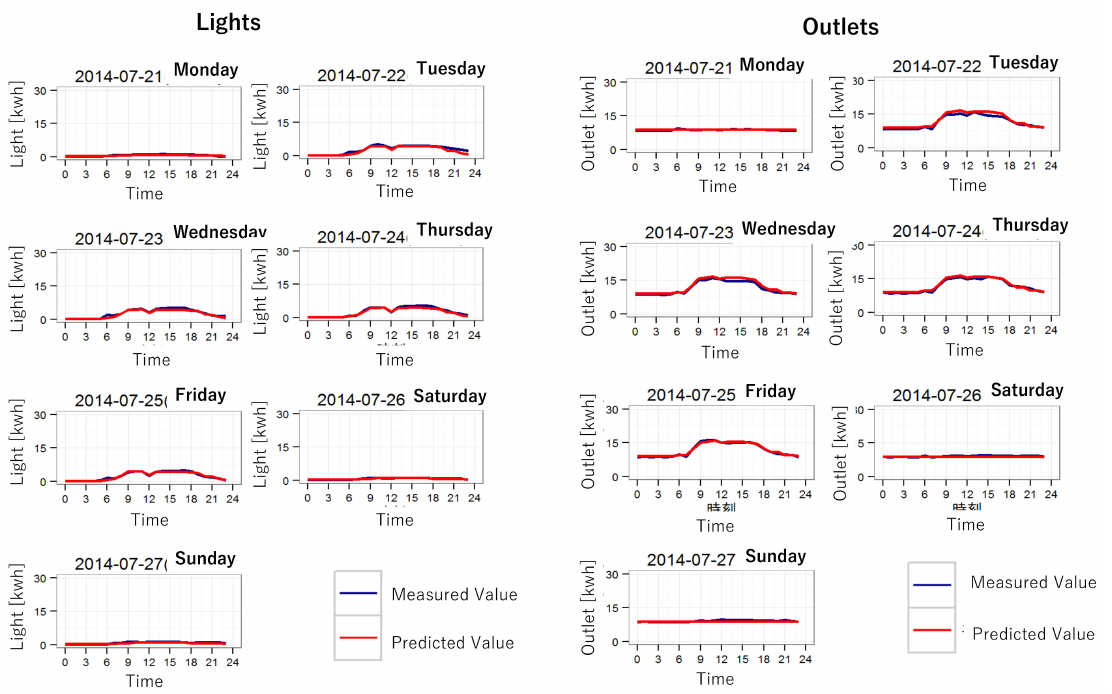
Figure 12. Results of the prediction for lights and outlets by the EP